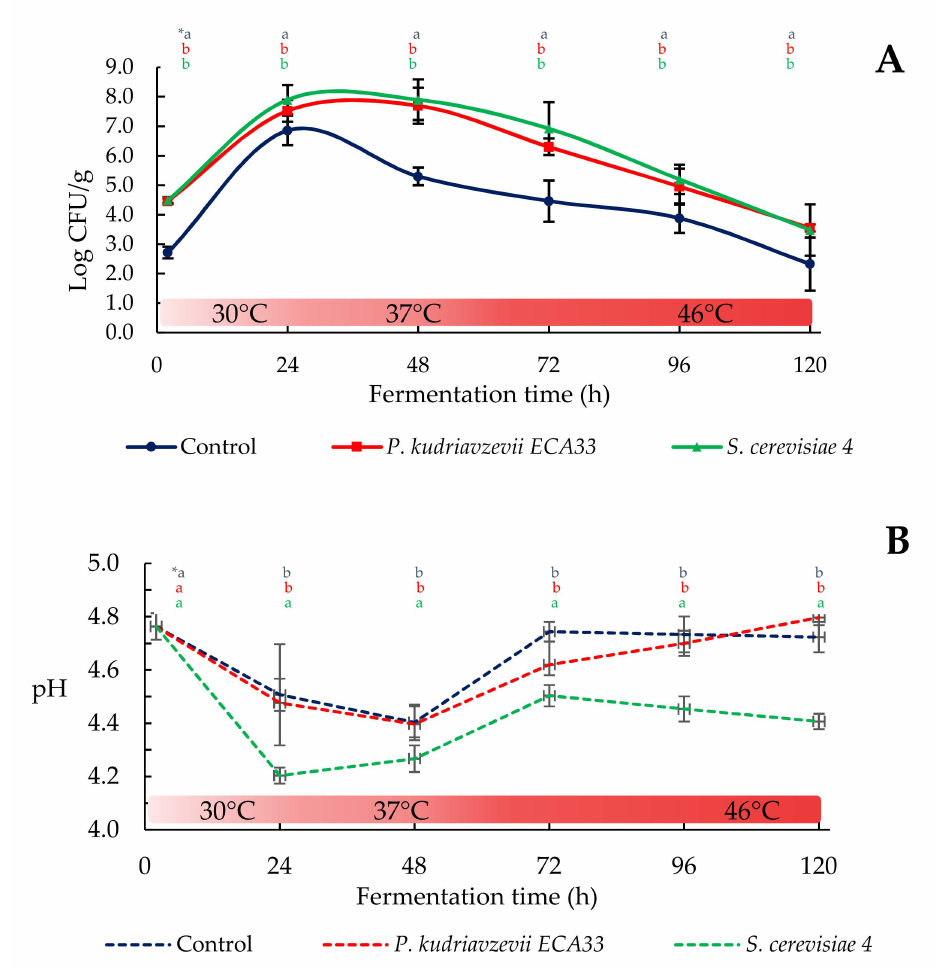
Figure 1. ( A ): Growth dynamics of the total yeasts during the simulated fermentation of re-hydrated cocoa beans. Batch inoculated with P. kudriavzevii ECA33 (red line), batch in- oculated with S. cerevisiae 4 (green line) and uninoculated control batch (blue line). ( B ): pH variation during the simulated fermentation of re-hydrated cocoa beans. Batch inocu- lated with P. kudriavzevii ECA33 (red dashed line), batch inoculated with S. cerevisiae 4 (green dashed line) and uninoculated control batch (blue dashed line). * Different letters in the same column (hour) indicate significant differences ( p < 0.05) among inoculated strains; first row Control, second row P. kudriavzevii ECA33, and third row S. cerevisiae